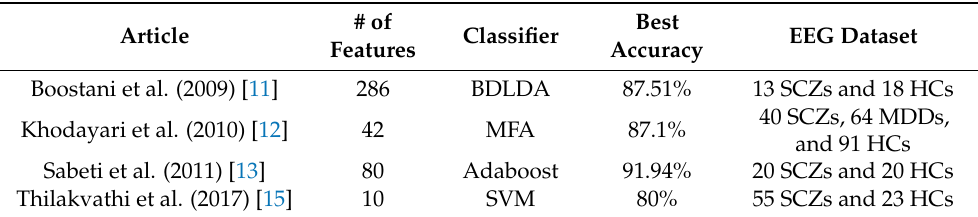
Table 1. Summary of most recent and accurate automated frameworks to diagnose schizophrenia using resting-state EEG